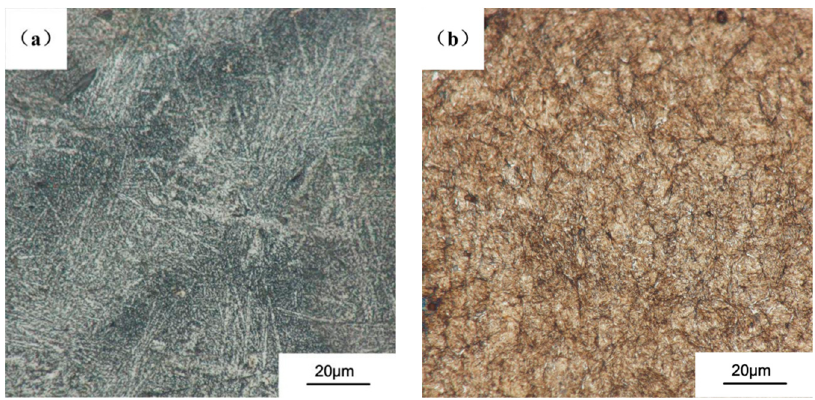
Figure 2. Microstructure of H13 steel: ( a ) As-cast; ( b ) heat treatment.